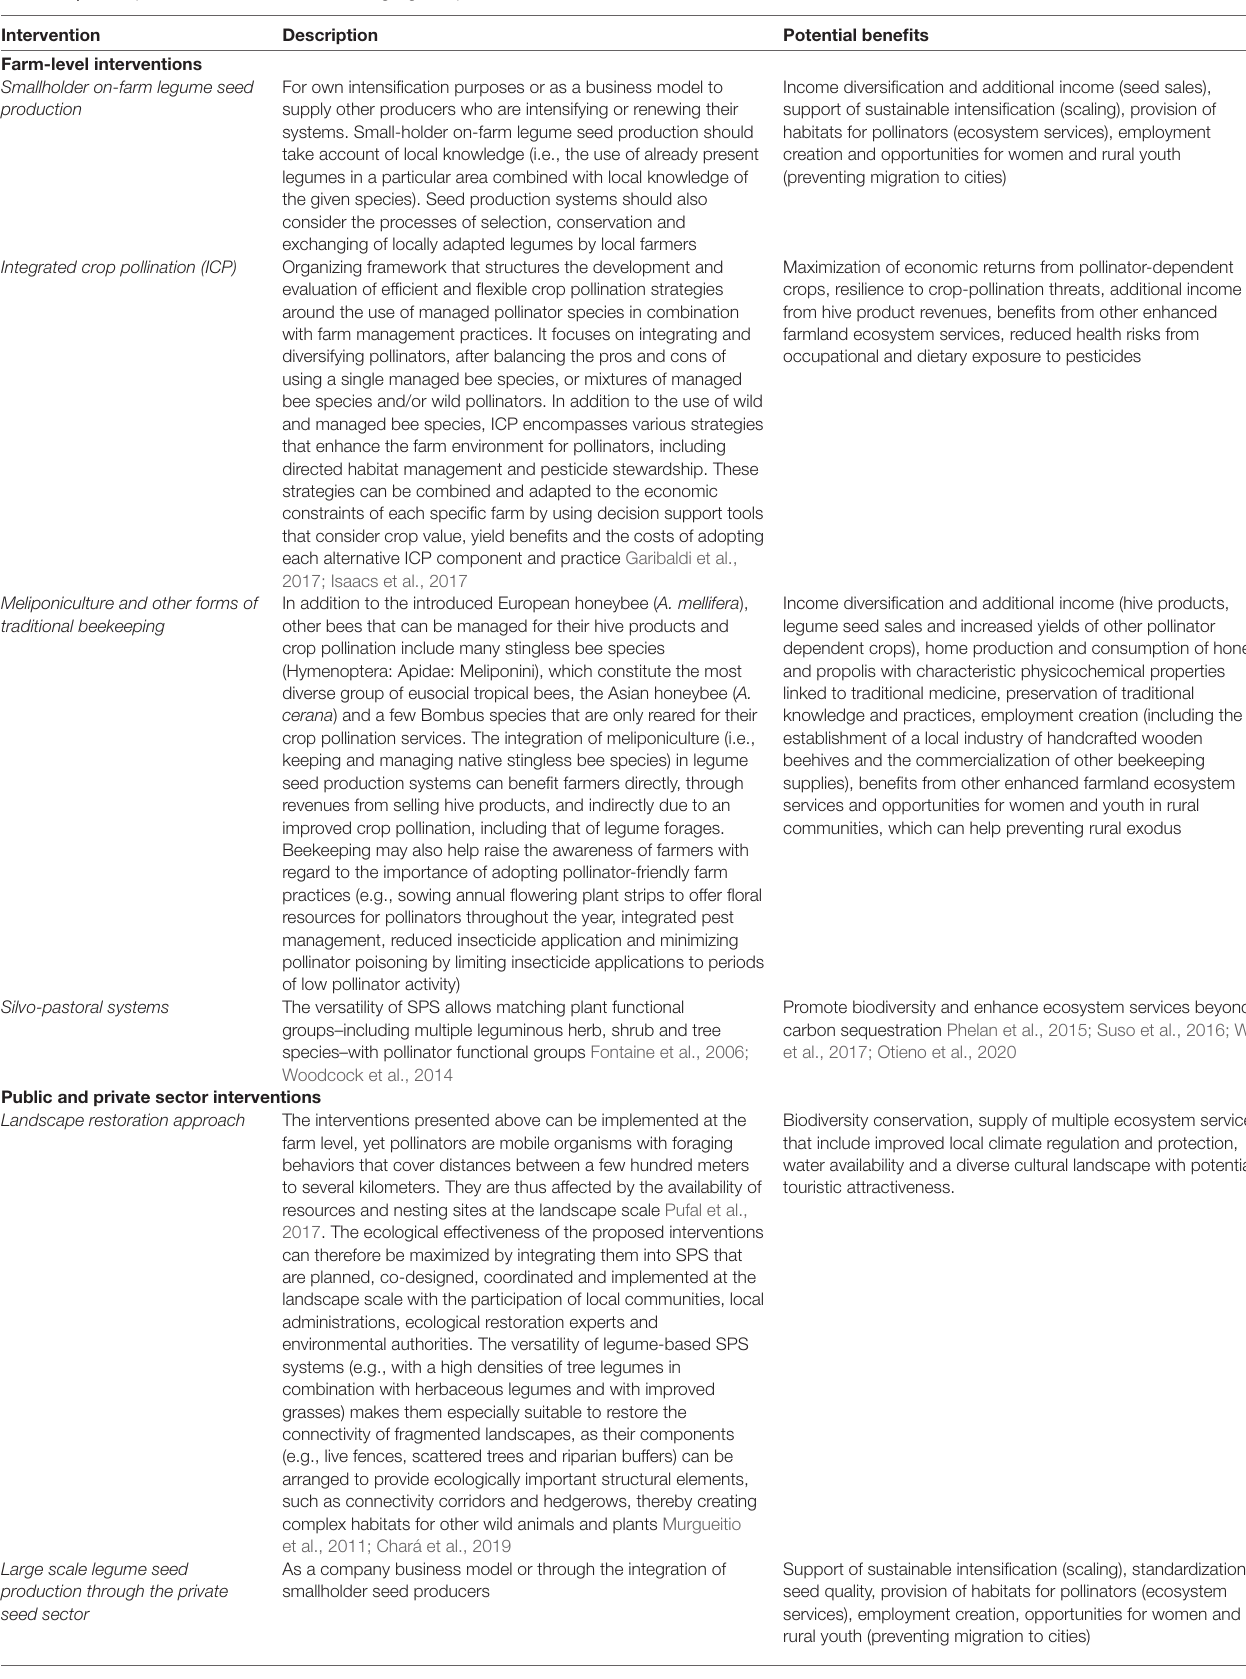
TABLE 2 | List of potential interventions considering legume-pollinator interactions. Intervention